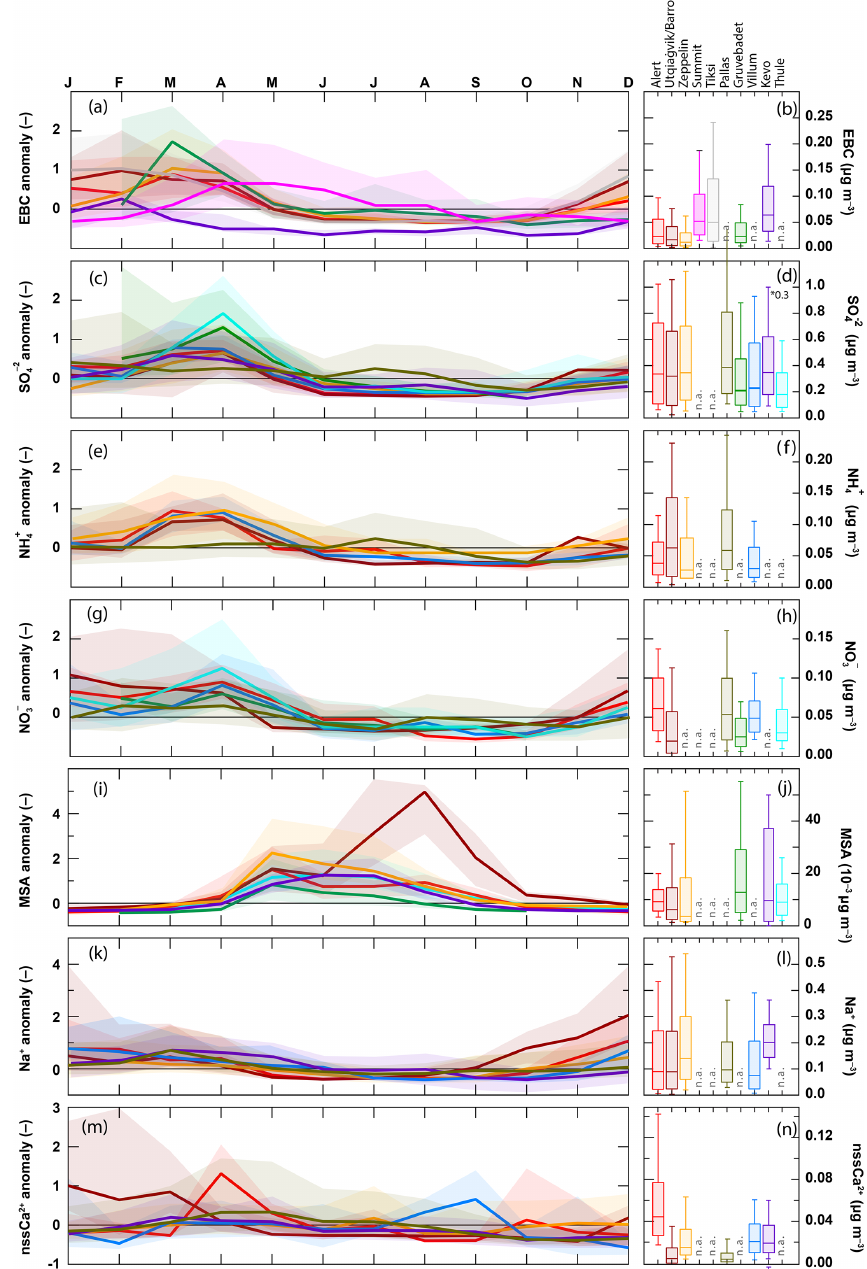
fires contributing during different times of the year. At Alert and Barrow/Utqia˙gvik the annual cycle of nssK + is similar to that of typical anthropogenic tracers, e.g., EBC, and has been identified as a haze tracer at Barrow/Utqia˙gvik by Quinn et al. (2002). Based on carbon isotope measurements and La- grangian dispersion modeling it has been shown that domes- tic wood burning is an important source of black carbon in winter (Stohl et al., 2013; Winiger et al., 2019). Hence, it is